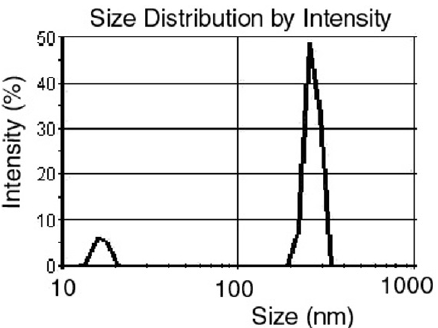
Figure 1. Particle size distribution of the sulfadiazine-chitosan (SDZ/CH) derivative suspension.